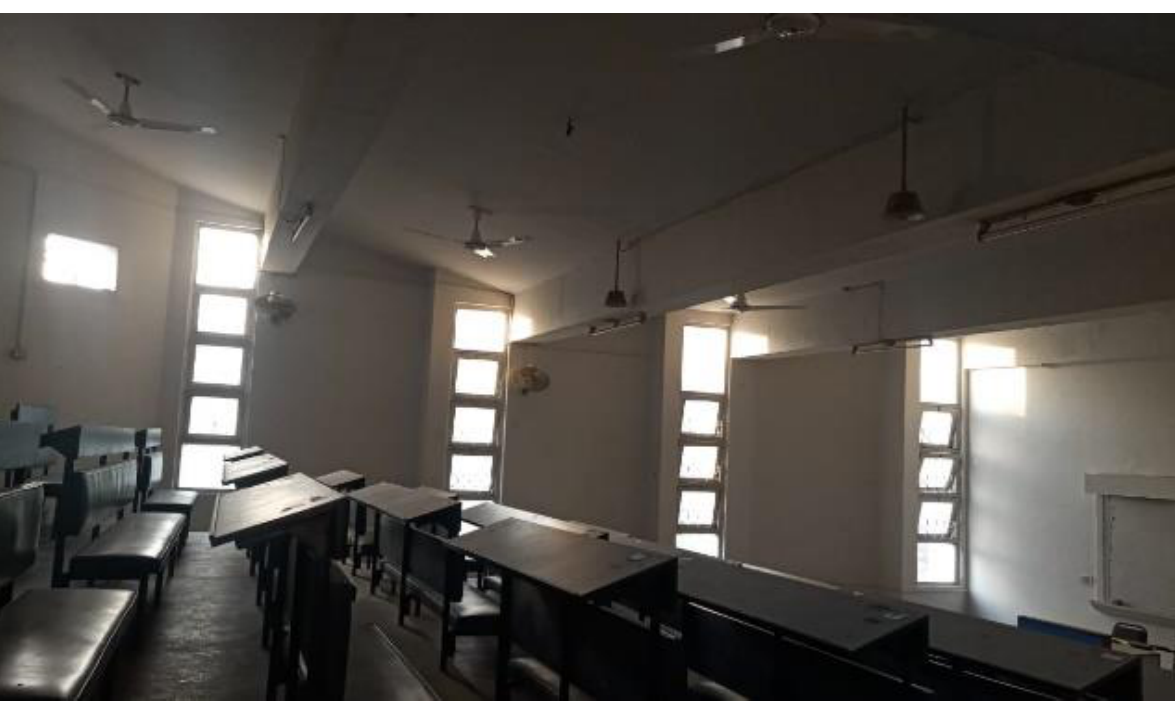
Figure 2. Lecture room used in this